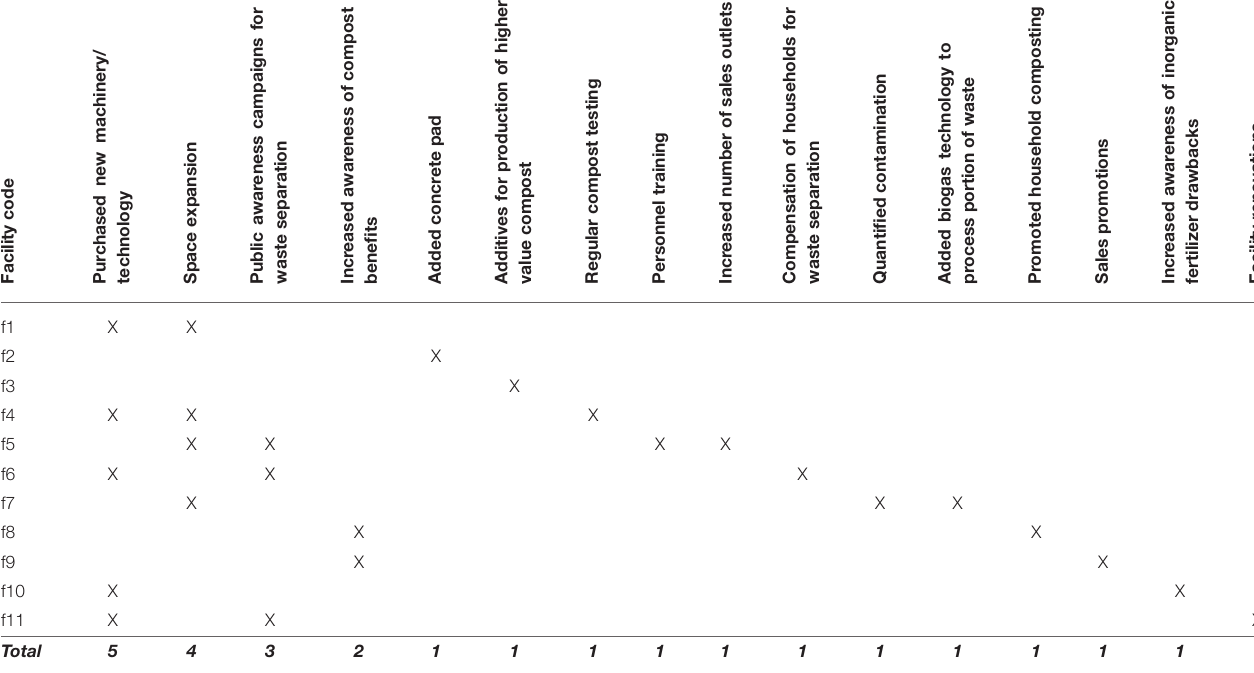
TABLE 4 | Key actions taken to solve problems identified by composting facility representatives in written questionnaires at the Colombo stakeholder